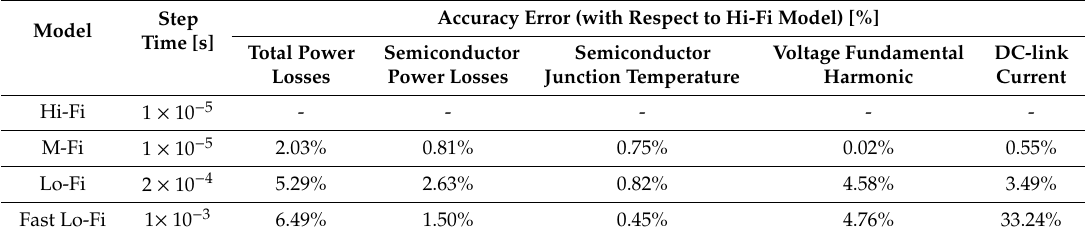
Table 3. Accuracy comparison between the di ff erent inverter physical